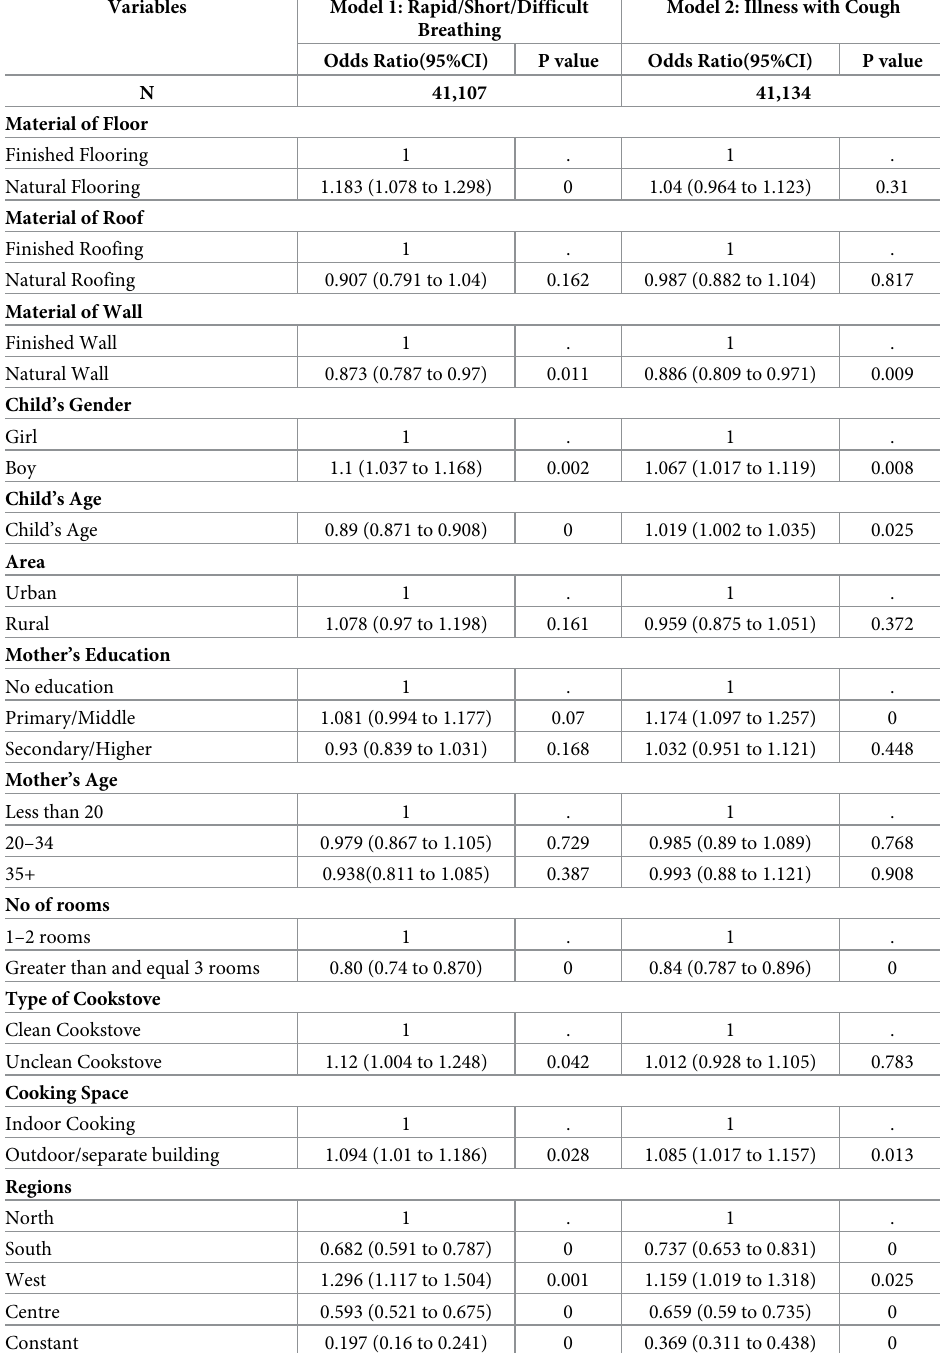
Table 5. Association between household characteristics, mother characteristics, child characteristics, region, resi- dence, and under-five ARI symptoms.